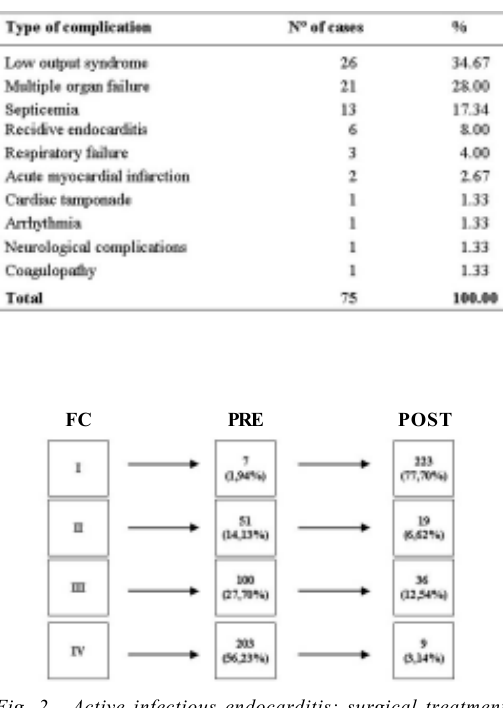
Fig. 2 - Active infectious endocarditis: surgical treatment Surgical treatment - functional class